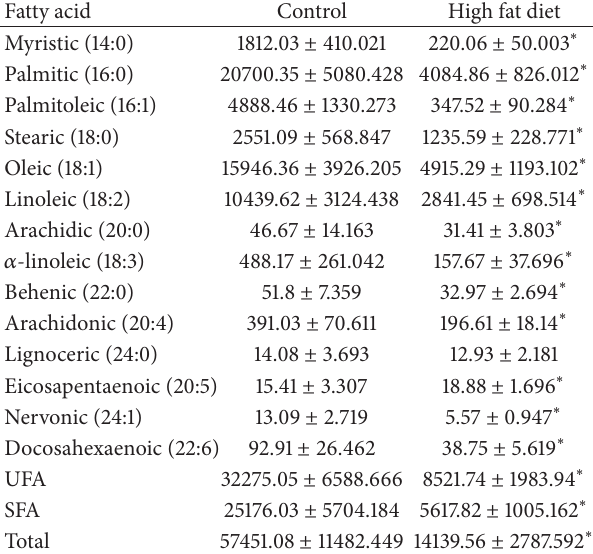
Table 4: Free fatty acids composition in the parotid salivary glands (nmol/g). Fatty acid Control High fat diet